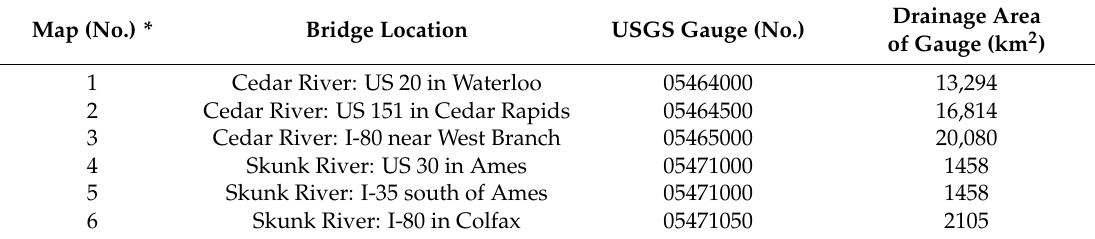
Table 1. Bridge locations and available stream gauges.